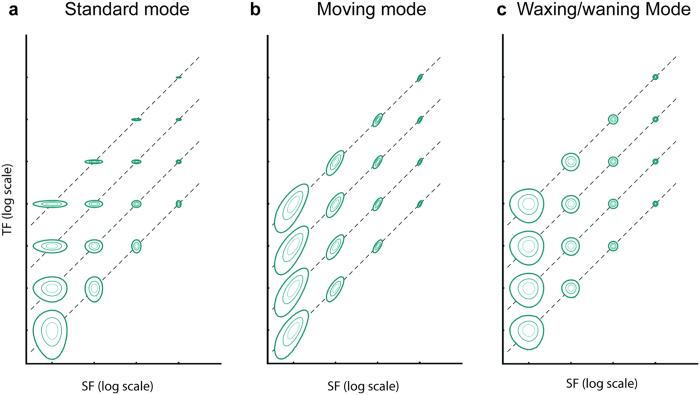
Schematic representations of the three stimulus modes in the Fourier space.The energy distributions of the Gabor patches displayed in the three modes are plotted in log-log scale. In this representation, SF and TF combinations that correspond to the same speeds (iso-speed lines, indicated by dashed lines in the figure) are tilted at 45° angles. Iso-speed lines closer to the x-axis represent slower speeds. In (b), the contours represent energy distributions of Gabor patterns passing through a fixed receptive field, whose envelope was modelled as a Gaussian function.